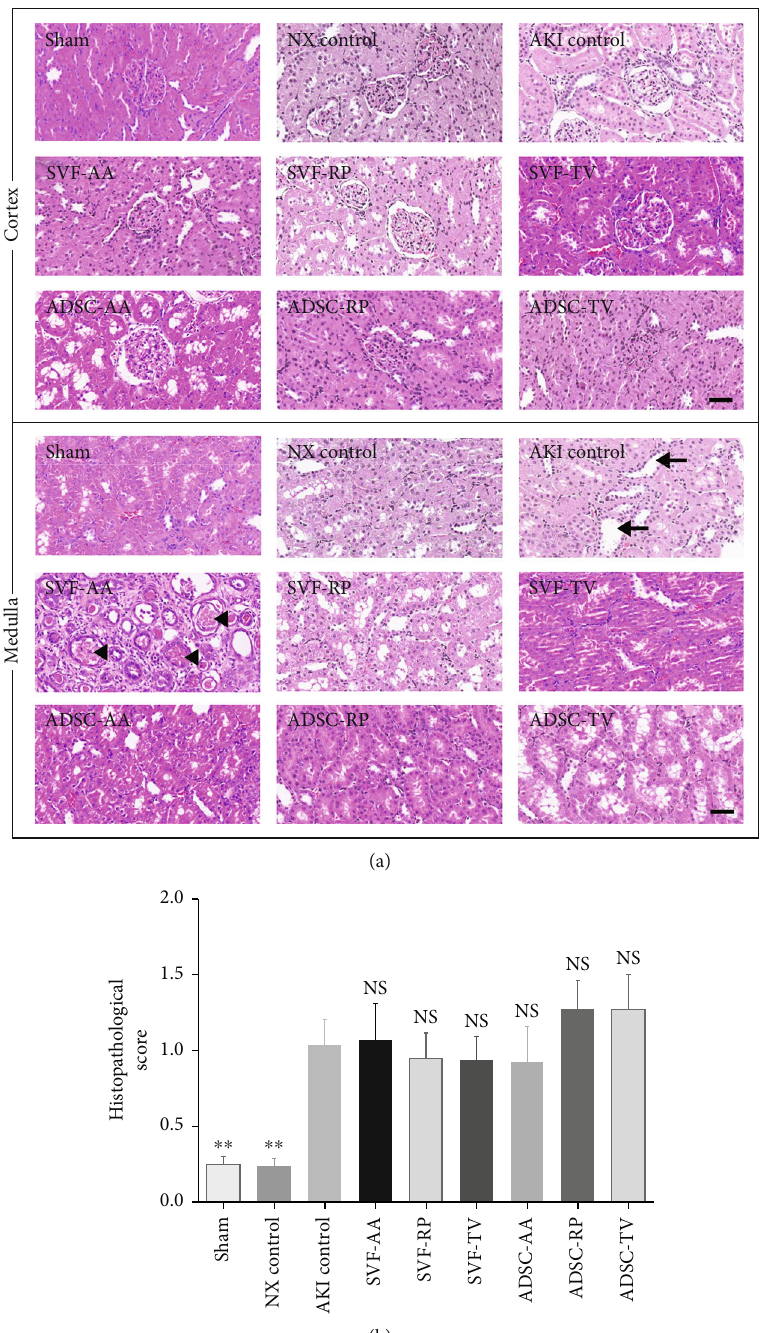
Figure 3: Histopathological score of kidney tissue. (a) Representative photomicrographs of cortex and medulla. Arrows and arrowheads indicate tubular dilatation and cast formation, respectively. (b) Histopathological score in random nonoverlapping fi elds. Magni fi cation × 40. Scale bar 50 μ m. NS, p > 0 : 05 ; ∗∗ p < 0 : 01 compared to the AKI control group. 10 fi elds per rat; 10 rats per group, but 8 rats in the SVF-AA and ADSC-AA